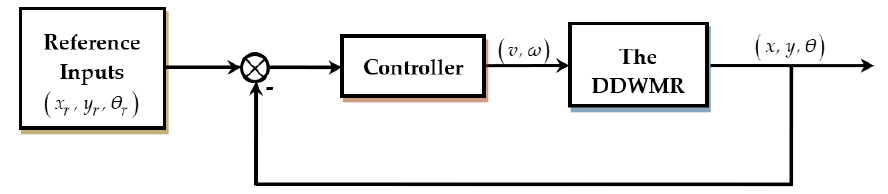
Figure 2. A general mobile robot motion control system.